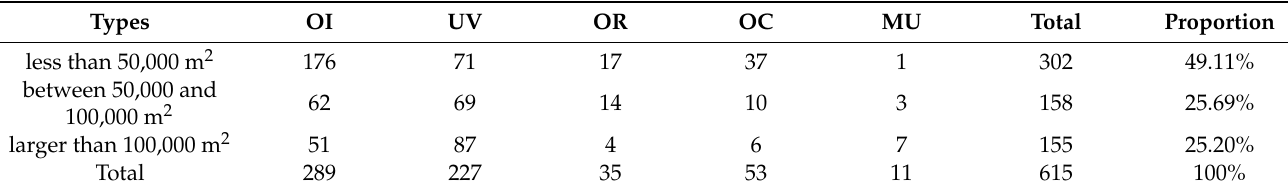
Table 5. Number of UR projects of different scales.